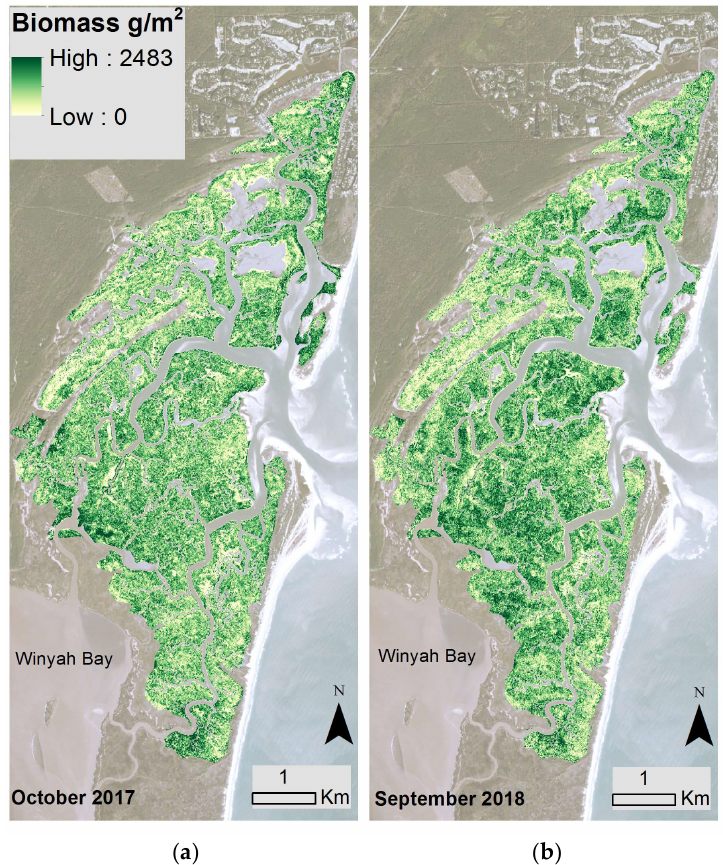
Figure 3. Modeled biomass from the back-transformation of Equation (2) across the marsh landscape at North Inlet from Planet satellite data acquired in ( a ) October 2017 and ( b ) September 2018. Basemap images courtesy of Planet Labs, Inc.